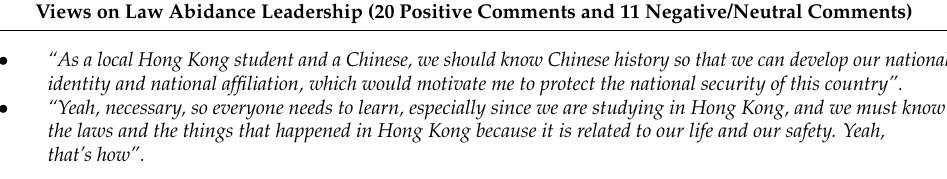
Table 5. Narratives of positive views on law abidance leadership education